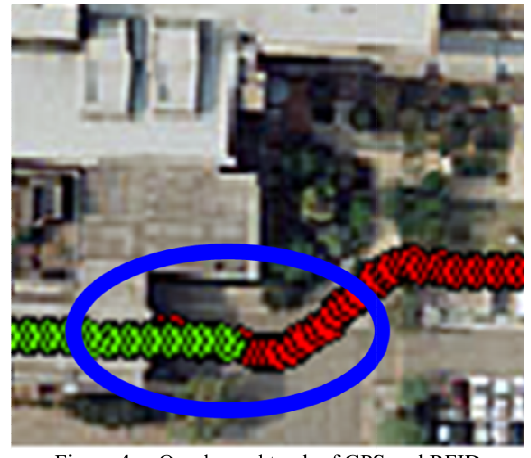
Figure 4. Overlapped track of GPS and RFID